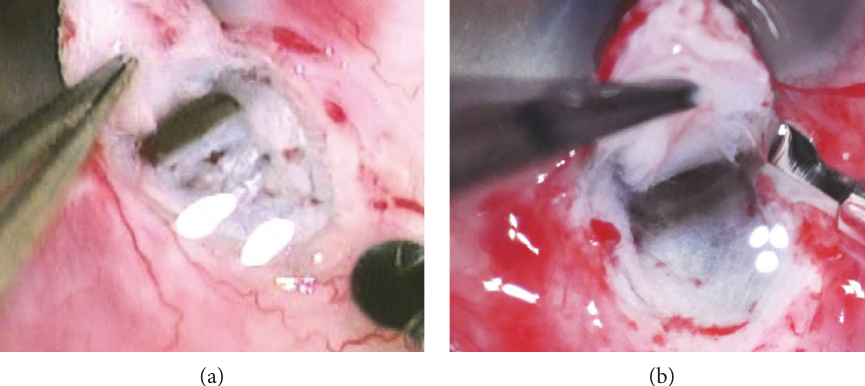
Figure 3: Deep sclerotomy in glaucoma surgery. (a) The border between Descemet ’ s membrane and the juxtacanalicular tissue was detected with poor visibility in the analog video. (b) Juxtacanalicular tissue was detected with excellent visibility using the 4K camera.